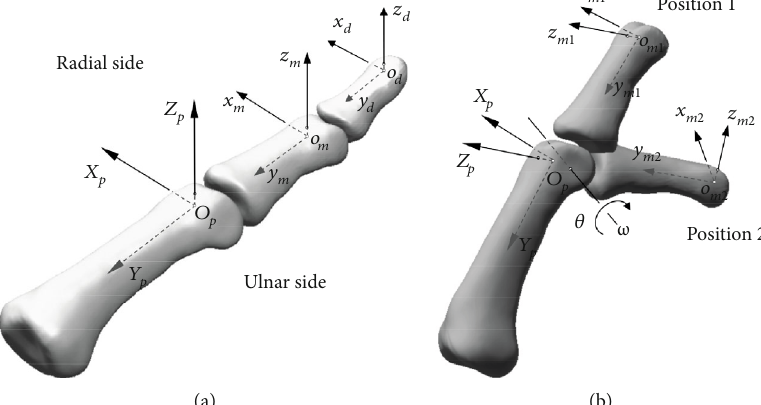
Figure 3: (a) Coordinate frames attached to each phalanx of a fi nger; (b) rotation of the middle phalanx about the PIP joint with respect to the proximal phalanx.